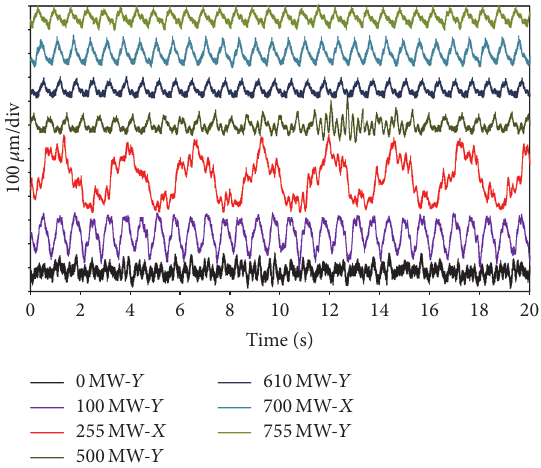
Figure 8: Shaft relative vibrations at several generator loads (0 to 755 MW, from bottom to top).